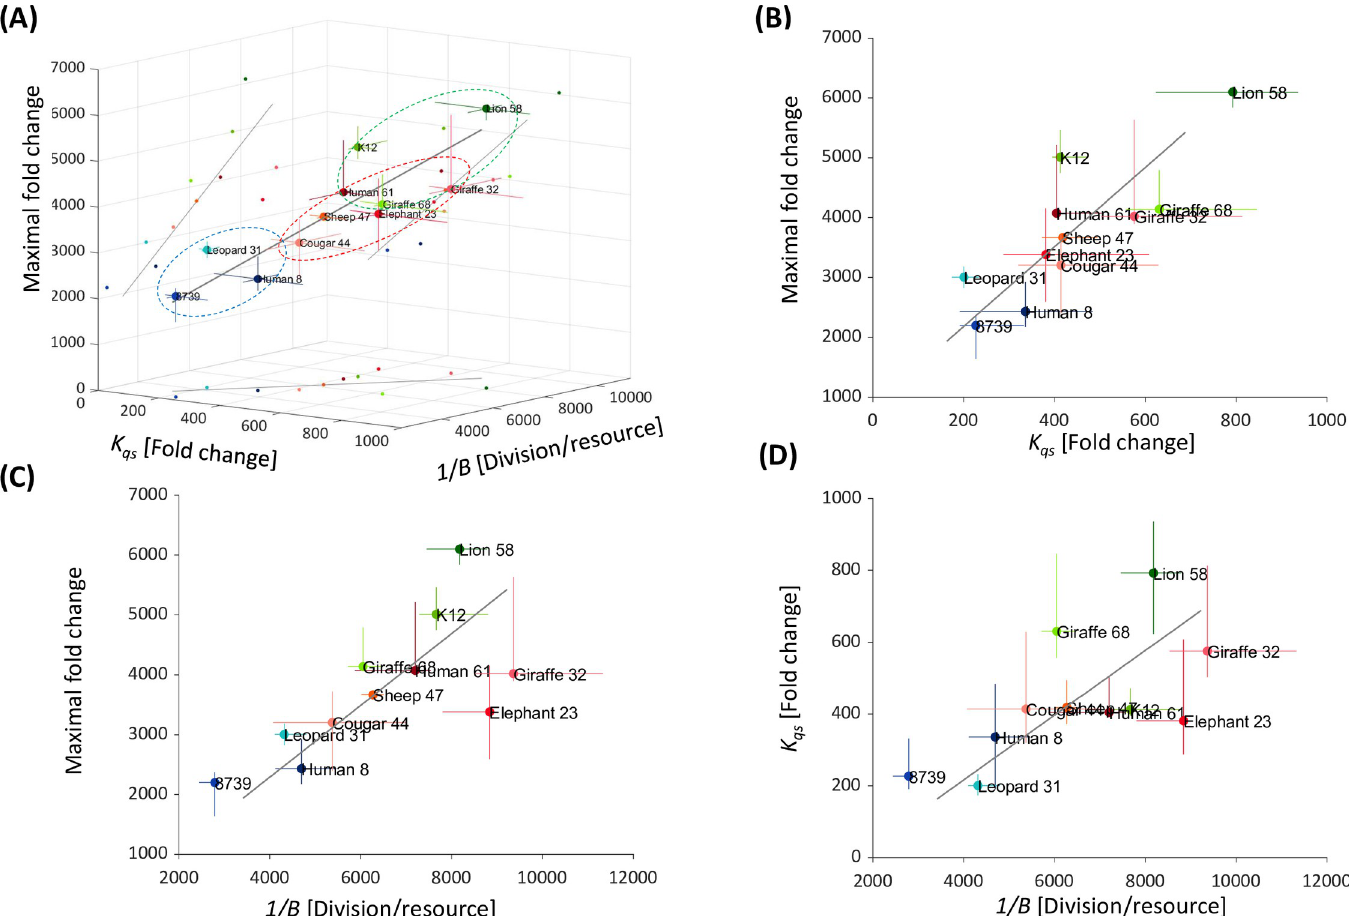
Fig 4. Maximal fold change is correlated with density-dependent effect and efficiency. (A) Maximal FC vs. K qs and 1/ B . The dots represent the median of each strain. The error bars are the 34 and 66 percentiles. The blue, red and green dashed-lined circles represent the group that emerged in the time series hierarchical clustering (Fig 1). The black lines are the first principal component and its projections. (B) Maximal FC vs. K qs . The gray line is the projection of the 3D first principal component. (Pearson: ρ = 0.81; p-value = 0.023). (C) Maximal FC vs. 1/ B (resource utilization efficiency). The gray line is the projection of the 3D first principal component, (Pearson: ρ = 0.69; p-value = 0.019). (D) K qs vs.1/ B . The gray line is the projection of the 3D first principal component, (Pearson: ρ = 0.63; p-value = 0.03).